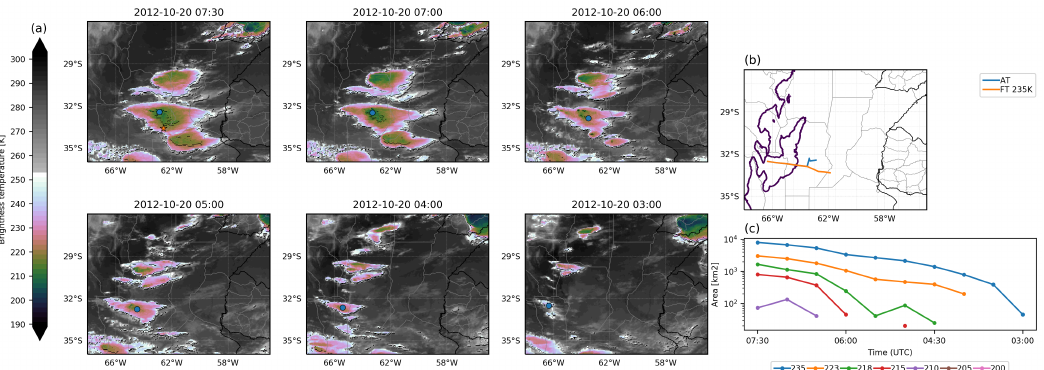
Figure 4. 20 October 2012: ( a ) Thermal infrared (TIR) brightness temperature starting at ERPF detection time until estimated initiation time. The light blue dot represents the centroid of the threshold cluster and the orange star the ERPF location. ( b ) Tracking trajectories for different techniques. AT (adaptive threshold) and FT (fixed threshold). 500 m height above sea level is added in black solid contour. ( c ) Time evolution of the size of the tracked system for different